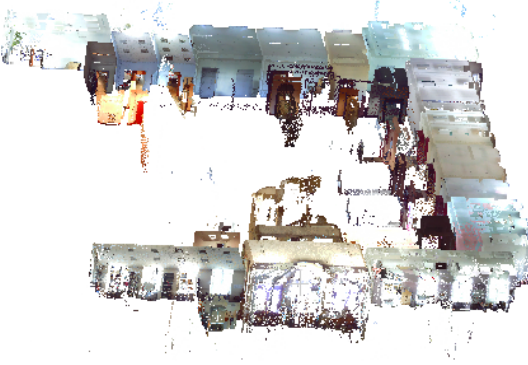
Figure 3. Indoor scans of the ground floor of the Zoological Museum of